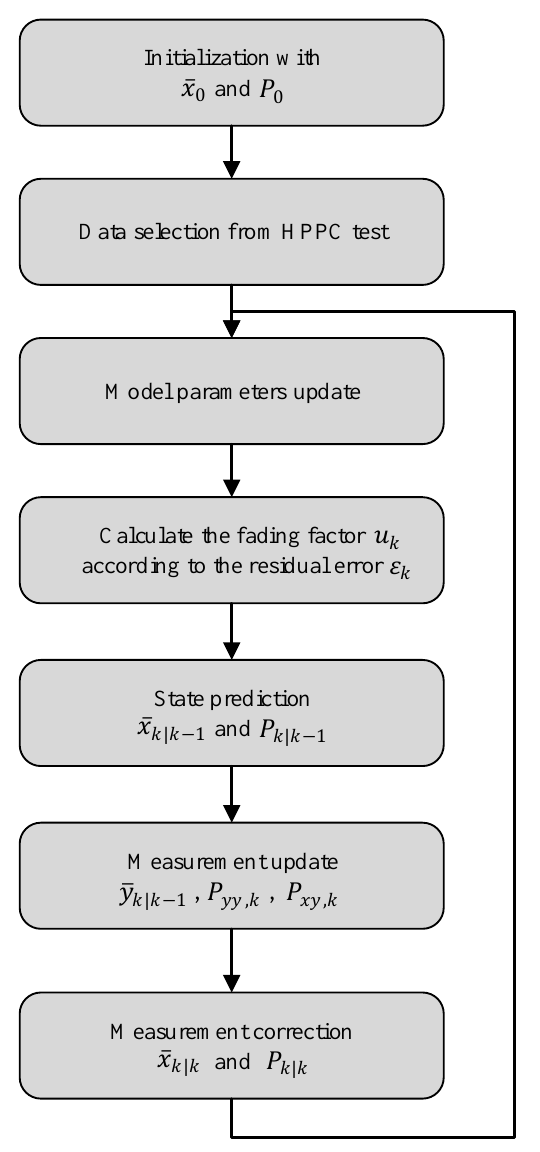
Figure 10. The flow chart of strong tracking filter (STF) algorithms.